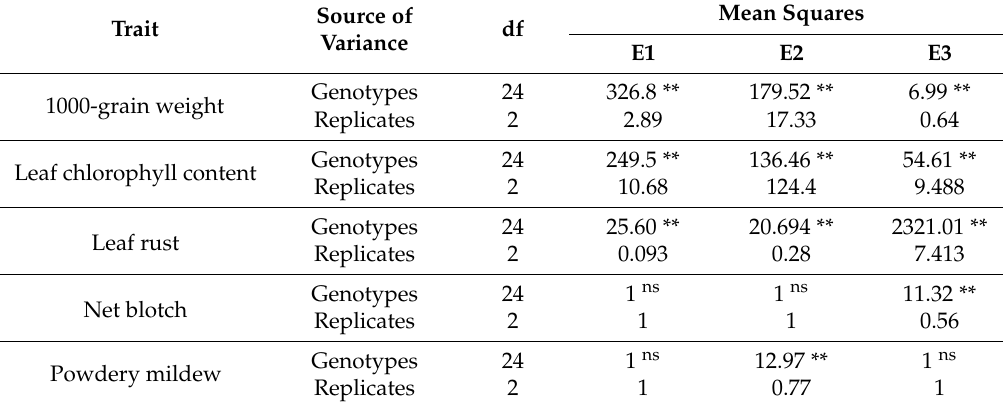
Table 2. Analysis of variance for 1000-grain weight (g), leaf chlorophyll content, leaf rust, net blotch and 2015/2016) and E3 (El-Bostan 2016/2017).